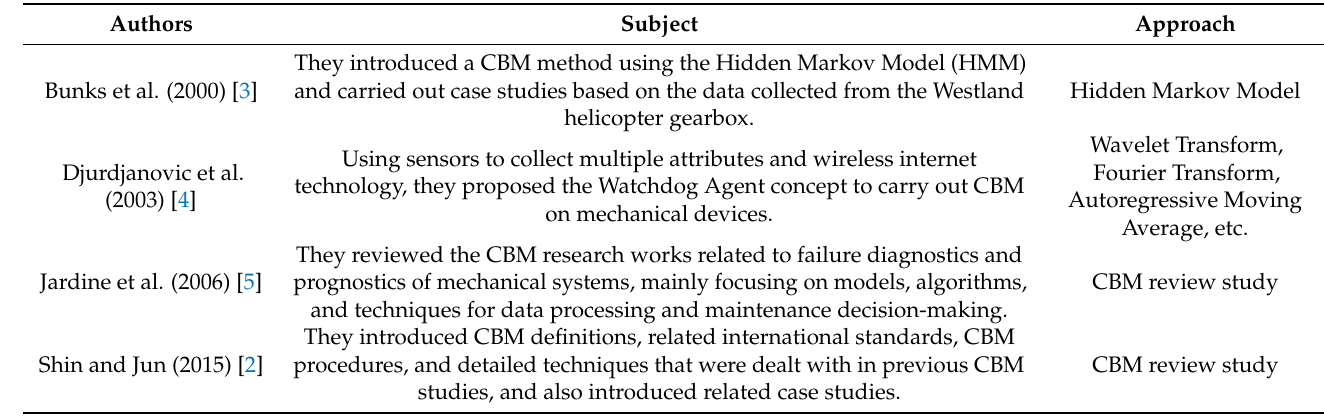
Table 1. Previous works on